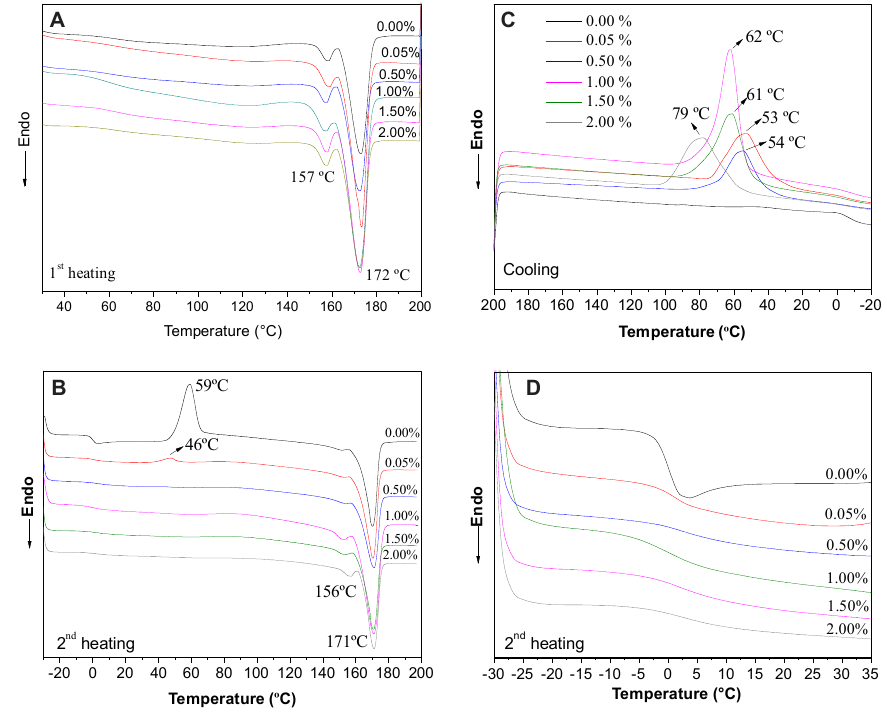
Figure 3. Differential scanning calorimeter (DSC) curves for neat poly(3-hydroxybutyrate- co -3-hydroxyvalerate) (PHBV) and its nanocomposites: ( a ) 1st heating; ( b ) cooling; ( c ) 2nd heating; and ( d ) glass transition region from 2nd heating.